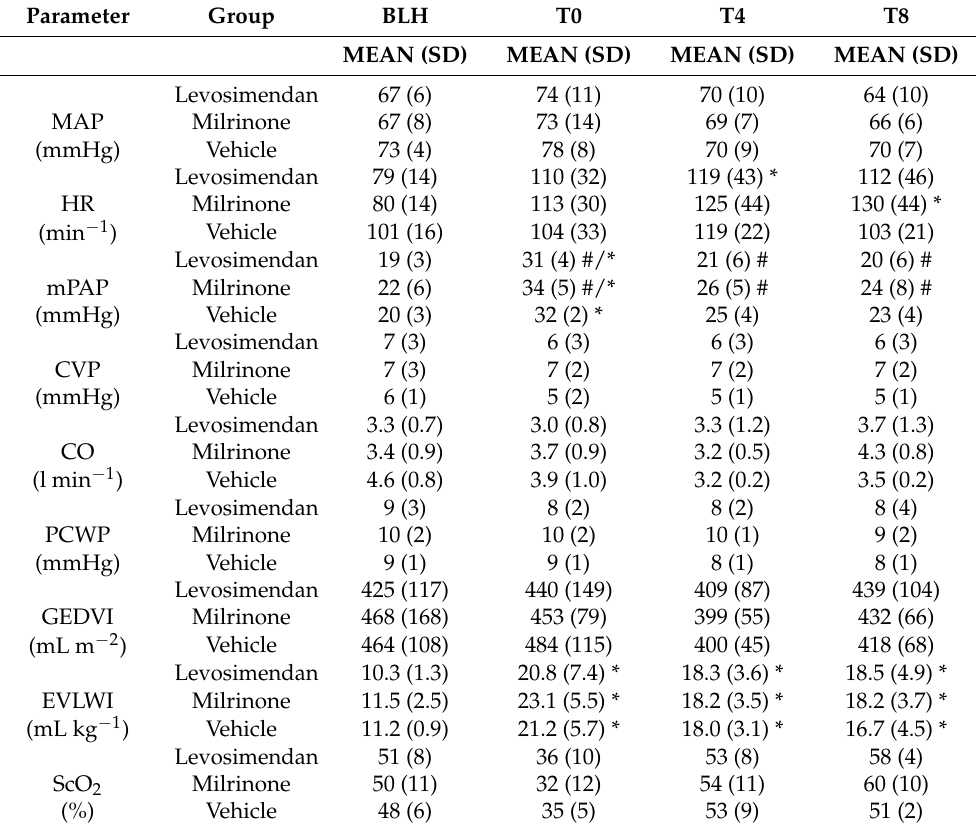
Table 2. Hemodynamic data over time. Values are mean (SD). * indicates p < 0.05 vs. baseline value. # indicates p < 0.05 in intergroup comparison. MAP: mean arterial pressure; HR: heart rate; mPAP: mean arterial pulmonary pressure; CO: cardiac output; PCWP: pulmonary capillary wedge pressure; GEDVI: global endiastolic volumen index; EVLWI: end-diastolic lung water index; CVP: central venous pressure; ScO 2 : cerebral oxygen saturation. BLH: baseline healthy.